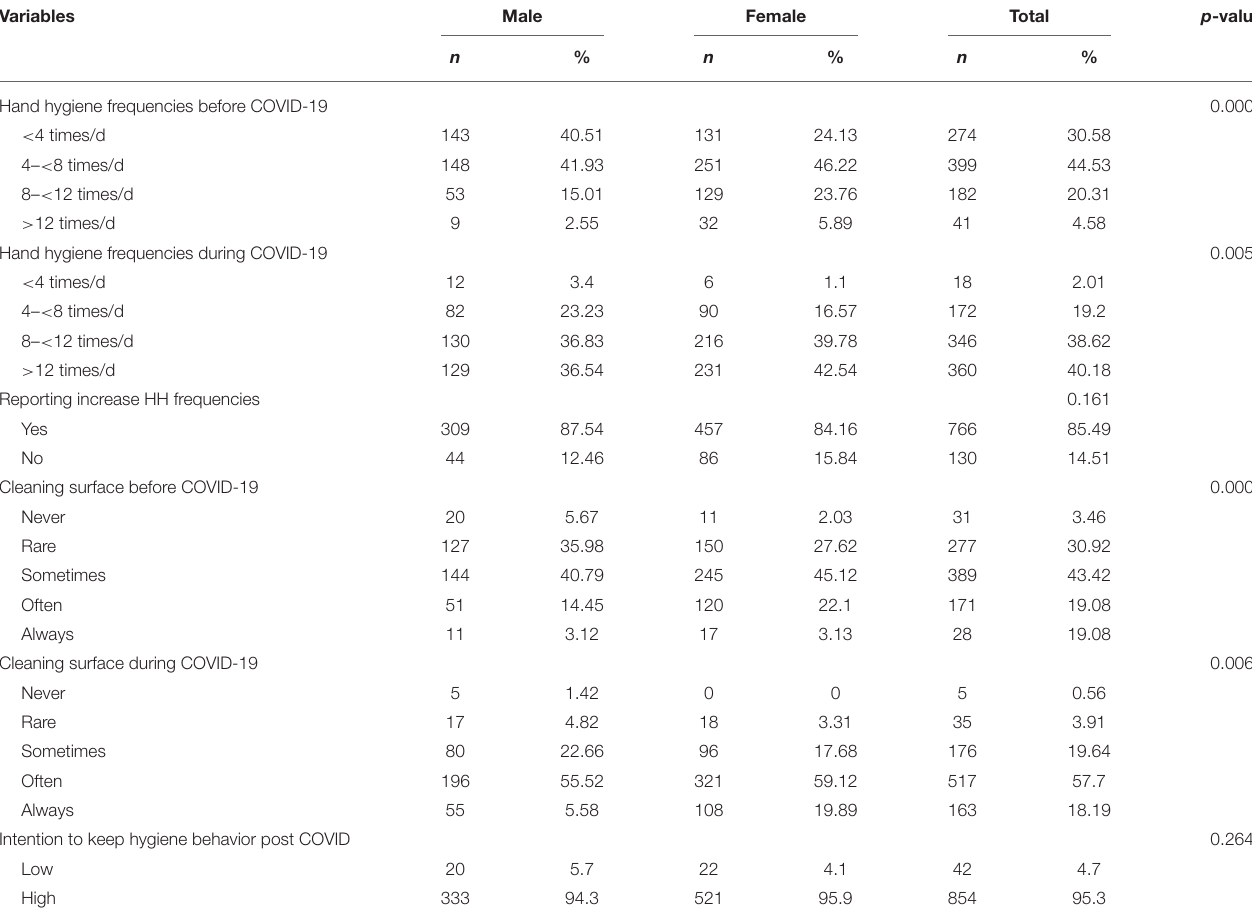
TABLE 2 | Differences of hygiene behavior between male and female.